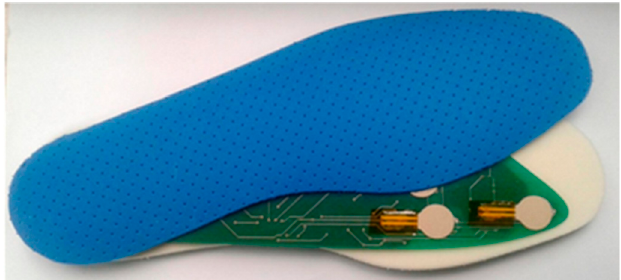
Figure 4. Prototype of smart insole. The flexible PCB is integrating between two antibacterial polyurethane-based